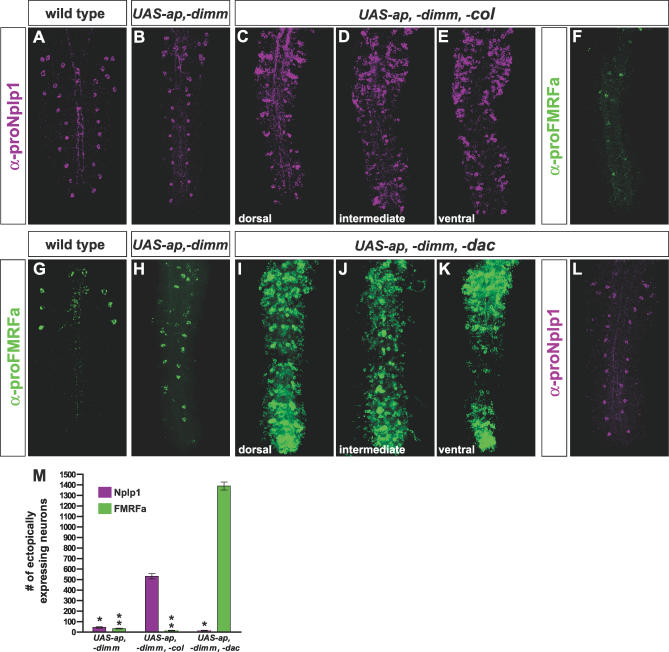
The Two Combinatorial Codes Act in a Highly Potent and Highly Selective MannerExpression of Nplp1 (A–E and L) and FMRFa (F–K).(A) Wild-type expression of Nplp1.(B) Co-misexpression of ap and dimm leads to some ectopic Nplp1 expression.(C–E) Ectopic Nplp1 expression is dramatically increased by addition of col to this code (to visualize the strong activation, the confocal “stack” of the VNC is split into three non-overlapping merged images).(F) The same VNC as in (C–E) revealing limited ectopic activation of FMRFa.(G) Wild-type expression of FMRFa.(H) Co-misexpression of ap and dimm also leads to some ectopic FMRFa expression.(I–K) Ectopic FMRFa expression is dramatically increased by addition of dac to this code.(L) The same VNC as in (I–K) revealing limited ectopic activation of Nplp1.(M) Quantification of the ectopic activation effects (n > 3 VNCs). A single asterisk denotes that the ectopic activation of Nplp1 is significantly reduced when adding dac to ap/dimm (Student t-test, p < 0.01). Similarly, double asterisks denote that the ectopic activation of FMRFa is significantly reduced when adding col to ap/dimm (Student t-test, p < 0.01).All images are from 18-h AEL VNCs.Genotypes: (A and G) w1118. Remaining panels are elav-GAL4 crossed to single or combinations of the various UAS-cDNA transgenes.